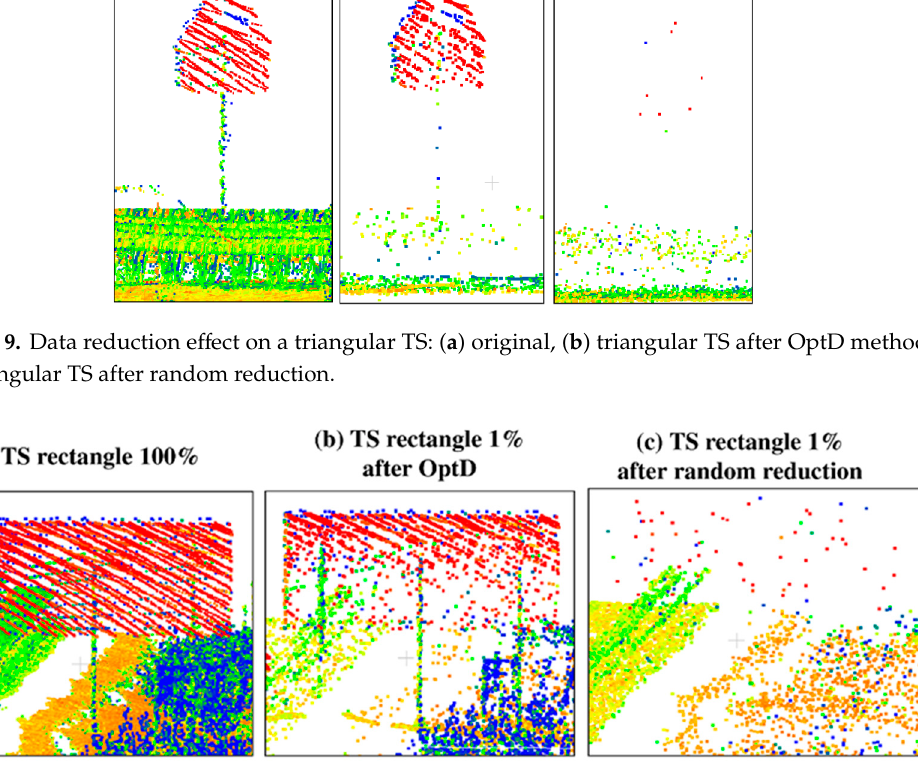
Figure 10. Data reduction effect on a rectangular TS: ( a ) original, ( b ) rectangular TS after OptD method, ( c ) rectangular TS after random reduction. Table 6. Effect of data reduction on TS points.